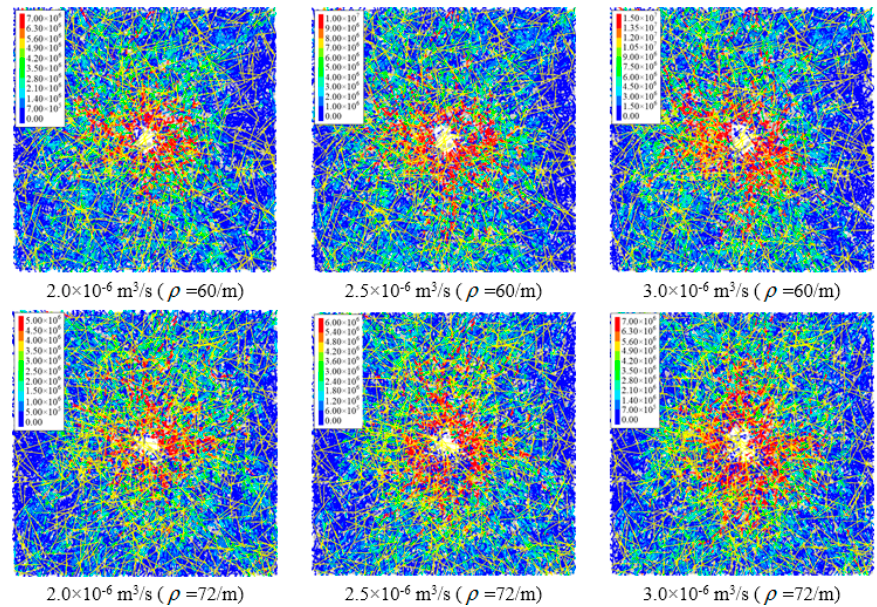
Figure 25. Change of injection pressure with injection rate when NF density ranges from 24/m to 72/m and S H : S h = 10:5.